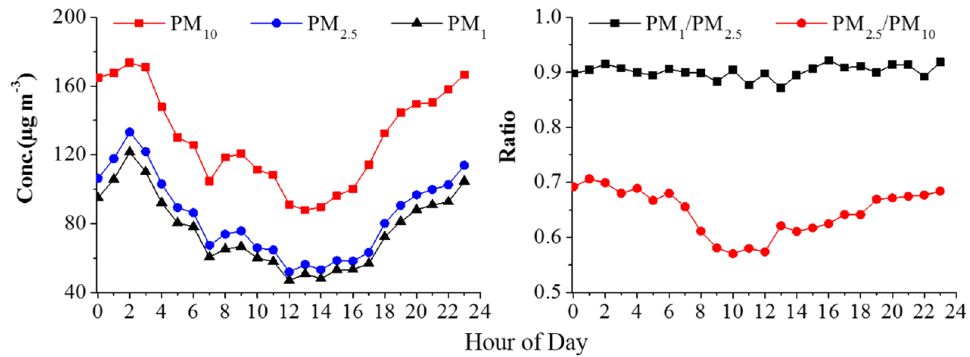
Figure 6. Diurnal profiles of PM 1 , PM 2.5 , PM 10 , and the ratio of PM 1 /PM 2.5 and PM 2.5 /PM 10 for the entire study. The ratio of PM 1 /PM 2.5 does not show obvious hourly variations during the entire study. The values remain high (~0.90) the whole day. However, the ratio of PM 2.5 /PM 10 shows apparent low